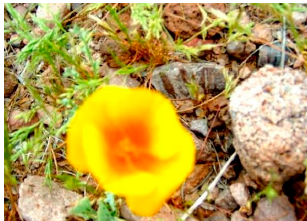
Figure 12. Original image.